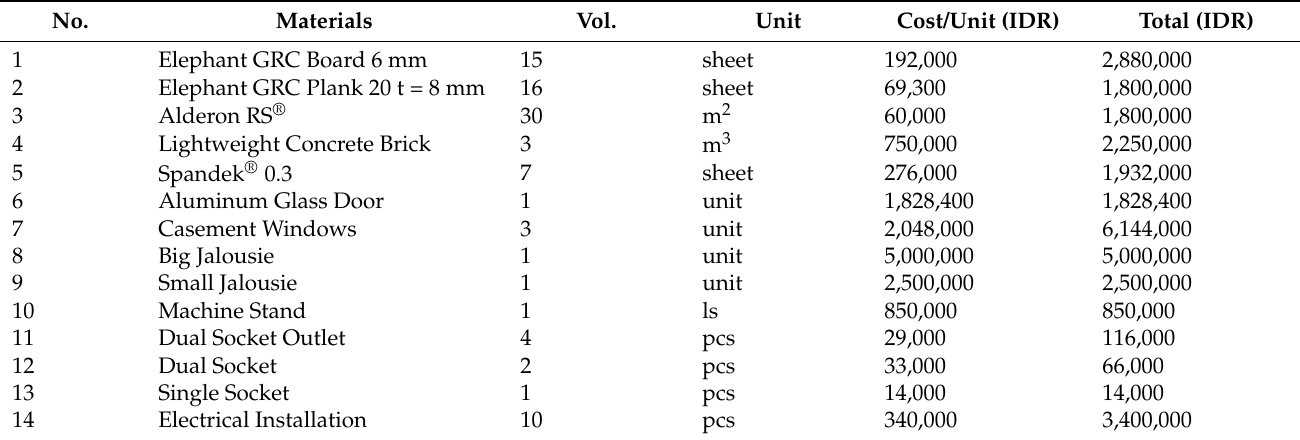
Table 2. Budget plan for prefab